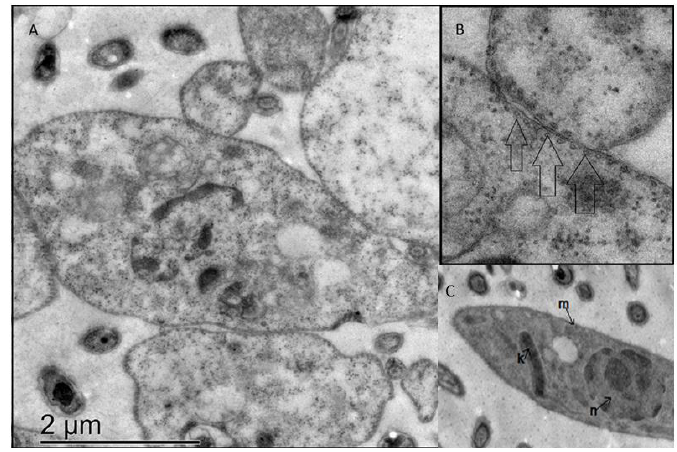
Figure 7. Transmission electronic microscopy images of a T. cruzi sample treated with 20 µM of ergosterol peroxide for 24 h. ( A ) treated sample, left panoramic, right amplification; ( B ) higher with arrows showing pores; ( C ) untreated sample showing (n) nucleus (m) membrane (k) kinetoplast. Biomolecules 2019 , 9 , x FOR PEER REVIEW